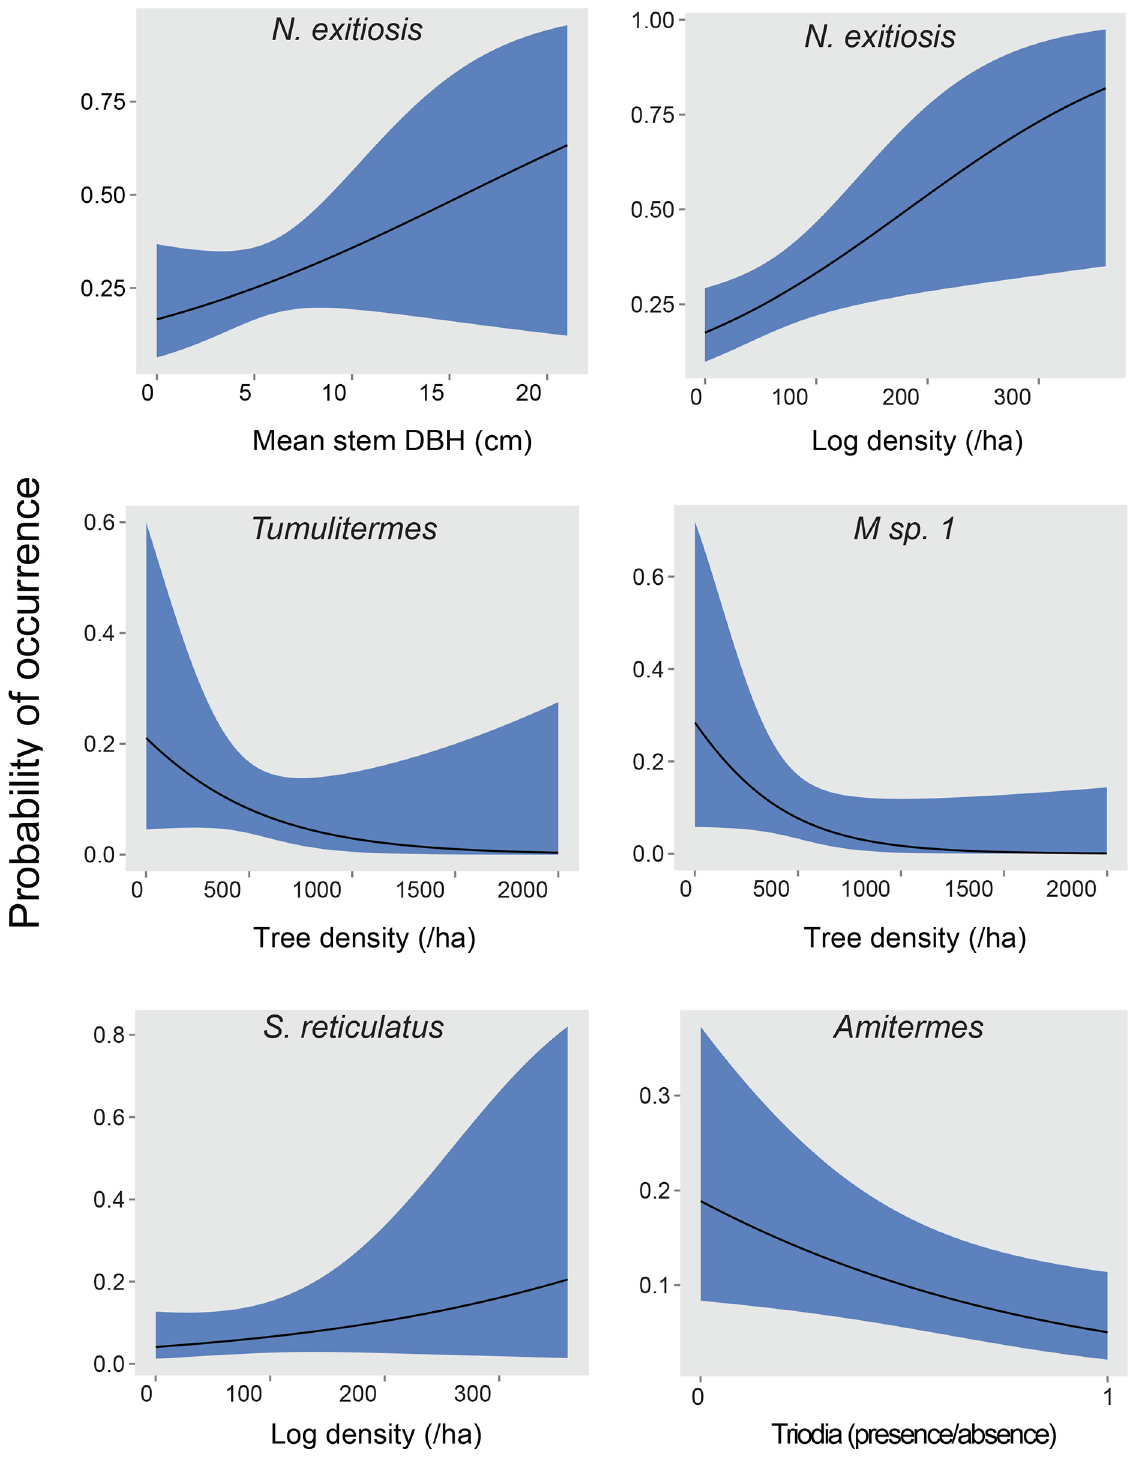
Fig 2. Responses of termite species to important explanatory variables at the site scale. Variables include density of trees, number of large logs, diameter of eucalypt stems and presence of Triodia scariosa . Solid lines represent predicted probability of occurrence from generalised linear mixed models, and shaded blue area represents ± 1